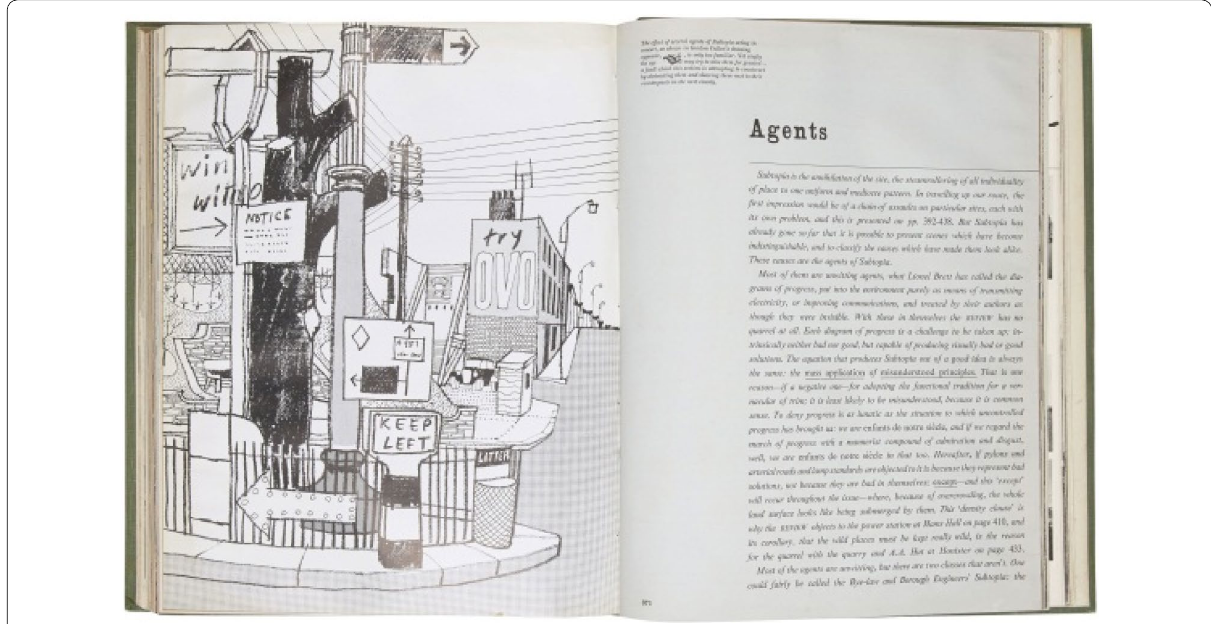
Fig. 7 Gordon Cullen’s illustrations enlivened the ‘Outrage’ special issue of The Architectural Review of June